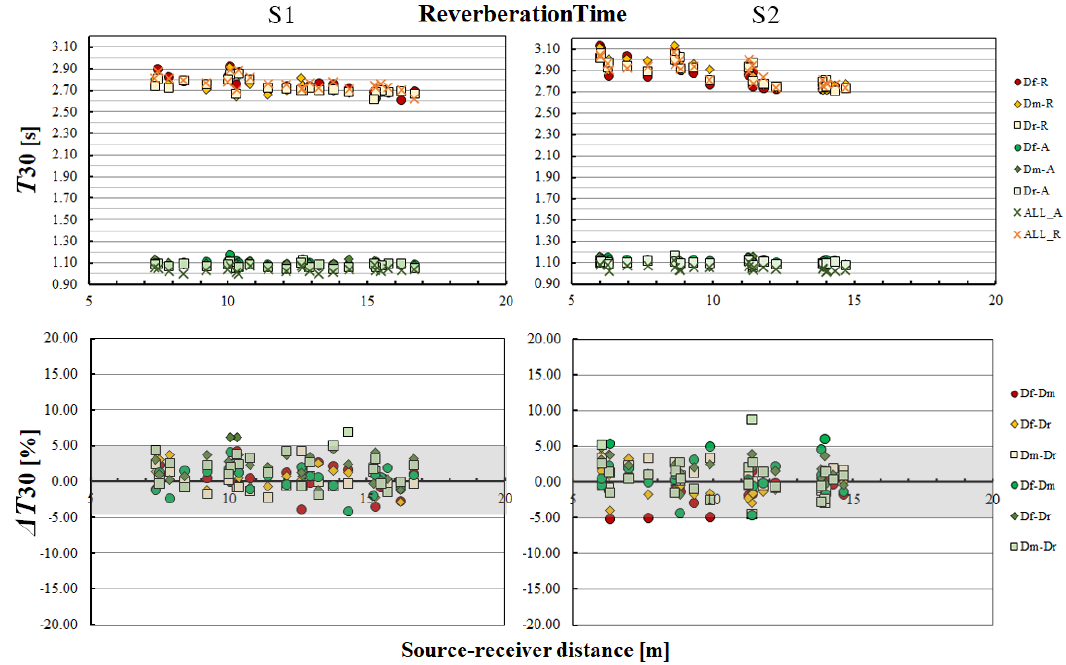
Figure 6. T 30 parameter averaged over 500 Hz and 1000 Hz for S1 and S2 source-to-receiver distance. Δ T 30 represent the parameter differences between the configurations Df-Dm, Df-Dr, Dm-Dr in the reflective (-R) and absorptive (-A) conditions. Differences equal ±1 JND of the parameters are highlighted through a gray area.